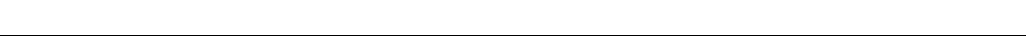
Fig. 1 A conditional strategy for ef fi cient depletion of ATR during male mouse meiosis. P30 testis and body weights ( a ), testis western blots ( b ), and periodic acid – Schiff and hemotoxylin/eosin-stained stage IV testis sections ( c ) in Atr fl / + Stra8-Cre males ( n = 9 males), Atr fl / – Stra8-Cre males ( n = 10 males), Atr fl / + Ngn3-Cre males ( n = 13 males) and Atr fl / – Ngn3-Cre males ( n = 13 males; means and p values for a indicated; unpaired t -test). Testis weights in Atr fl / + Stra8-Cre and Atr fl / + Ngn3-Cre males are not signi fi cantly different from those in Atr fl / + Cre negative males derived from the same crosses ( n = 17 Atr fl / + Cre negative males from the Stra8-Cre cross, p = 0.37, n = 11 Atr fl / + Cre negative males from the Ngn3-Cre cross, p = 0.06). Inset in c shows presence of elongating spermatids in some tubules from Atr fl / – Stra8-Cre males. d , e ATR (magenta) and SYCP3 (green) staining in Atr fl / + Ngn3-Cre (denoted Atr fl / + ) and Atr fl / – Ngn3-Cre (denoted Atr fl / – ) males. In Atr fl / + males ( n = 2 males) ATR is observed as foci (see insets) in 85% of leptotene cells ( n = 20 cells) and 82% of zygotene cells ( n = 28 cells), and on the asynapsed region of the XY bivalent in 100% of pachytene cells ( n = 30 cells). In Atr fl / – males ( n = 2 males) ATR is observed in no cells at these three stages ( n = 21, 30 and 32 cells at leptonema, zygonema and pachynema, respectively). f Validation of ATR depletion in Atr fl / – by analysis of MSCI. In Atr fl / + males, all pachytene cells show coating of the X and Y chromosome (arrowheads) but not the pseuodautosomal regions (PAR, arrowhead) by γ H2AX (magenta; left panels; XY bivalent in box magni fi ed in smaller panels). This coating causes silencing of the X-chromosome gene Scml2 (magenta; right panels) and compartmentalization of the XY bivalent (labeled with HORMAD2; green) in the sex body ( n = one male, 29 cells; magni fi ed in smaller panels). g In Atr fl / – males, XY chromosome γ H2AX coating and sex body compartmentalization do not occur. As a result, Scml2 expression (arrow) persists in all early pachytene cells ( n = one male; 30 cells). Scale bar in ( c ) 20 µ m, other scale bars 10 µ